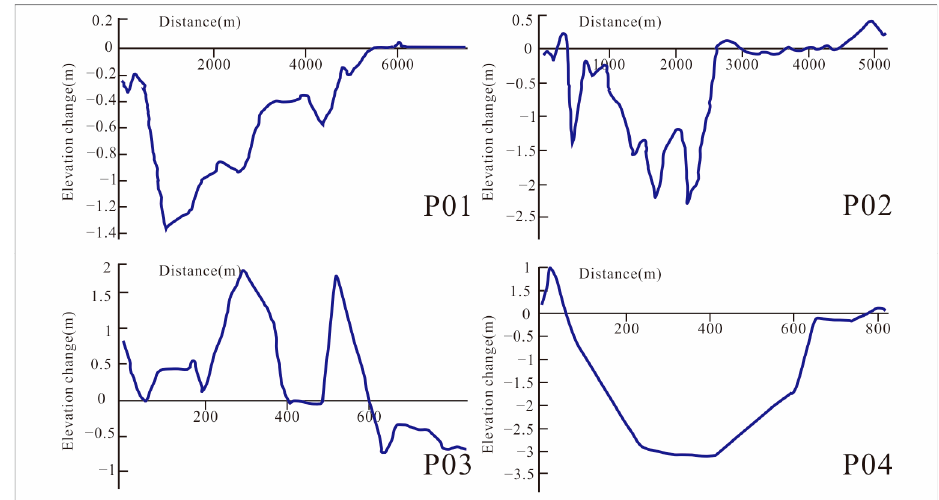
Figure 7. Isobath and scouring–siltation changes between Luanjiakou Port and Taozi Bay.